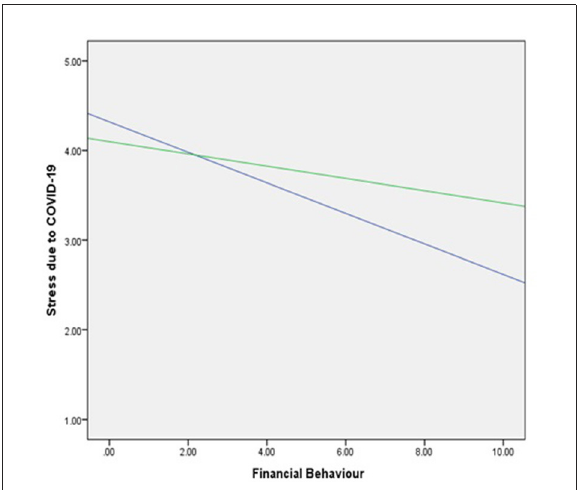
FIGURE1 Moderation of gender between COVID-19 distress and financial